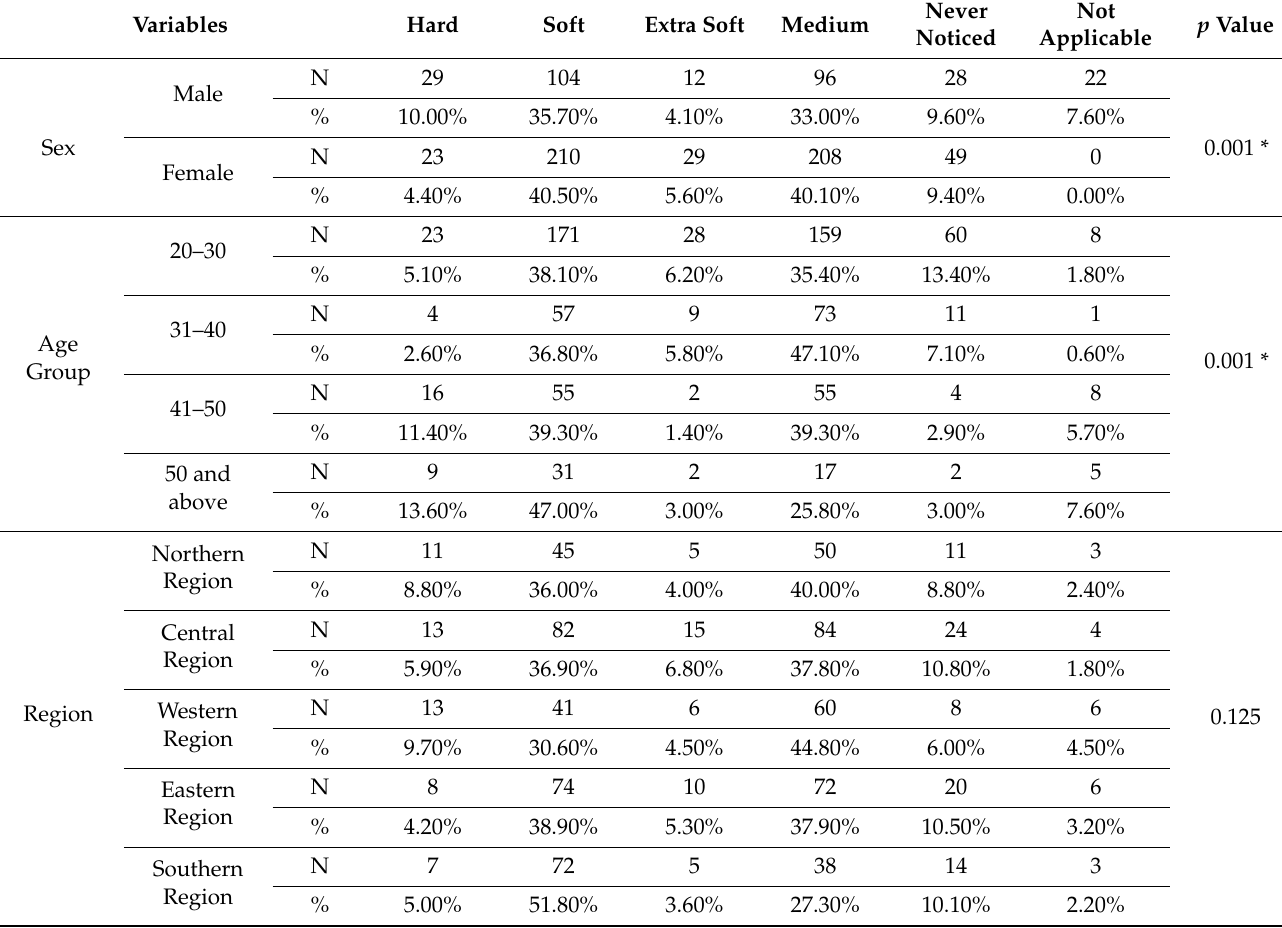
Table 4. Perception and knowledge of different parameters on “The type of brush you use?”.